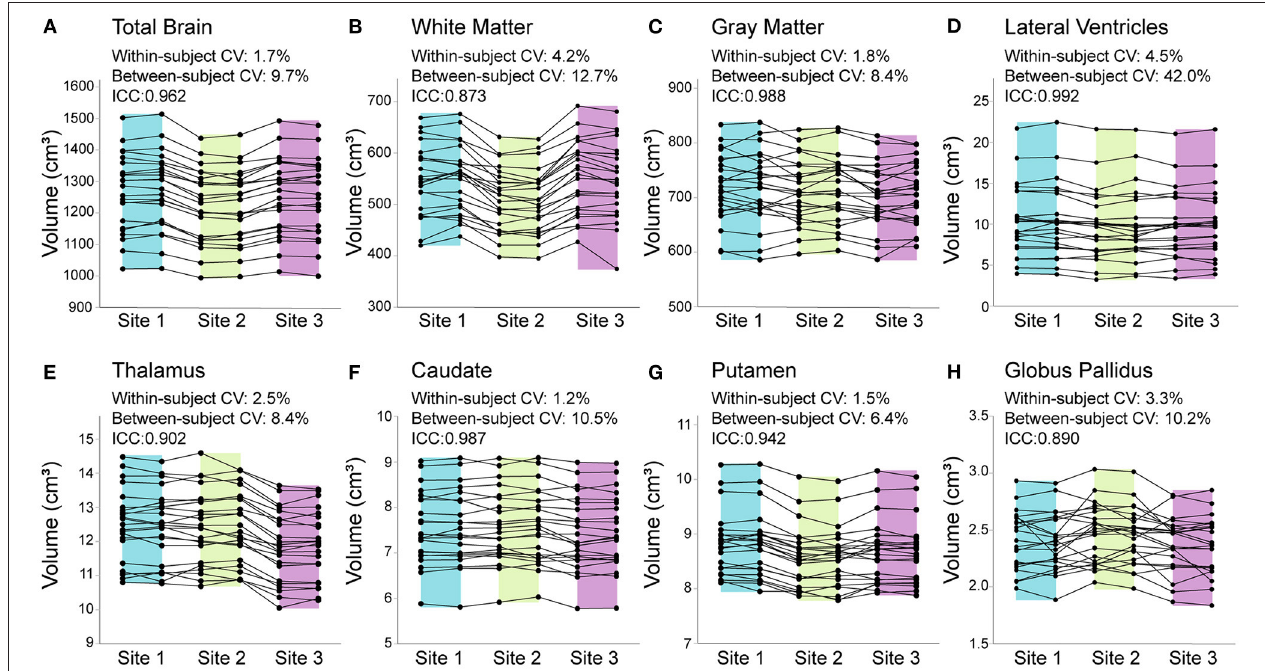
FIGURE 2 | Total brain (A) , white matter (B) , gray matter (C) , lateral ventricle (D) , thalamus (E) , caudate (F) , putamen (G) , and globus pallidus (H) volumes from all 23 traveling phantom participants scanned twice each at each of the 3 sites (138 datapoints per structure total). Percent change in consecutive scans within subject at each site was < 1% for all structures (at all sites), except lateral ventricle and white matter volume at Site 3 (FMC), which had 1% and 1.6% difference (respectively) between test–retest scans. Coefficient of variation (CV) within–participants across the 3 sites ranged from 1.2% [ (F) caudate] to 4.5% [ (D) lateral ventricles], while between–participant CV was much larger for all structures, ranging from 6.4% [ (G) putamen] to 42% [ (D) lateral ventricles]. Intraclass correlation coefficients (ICCs) suggested excellent agreement between scanners, ranging from 0.873 [ (B) white matter] to 0.992 [ (D) lateral ventricles]. Shading indicates the range for each site (Site 1/UofA – blue; Site 2/ACH – green; Site 3/FMC – purple).